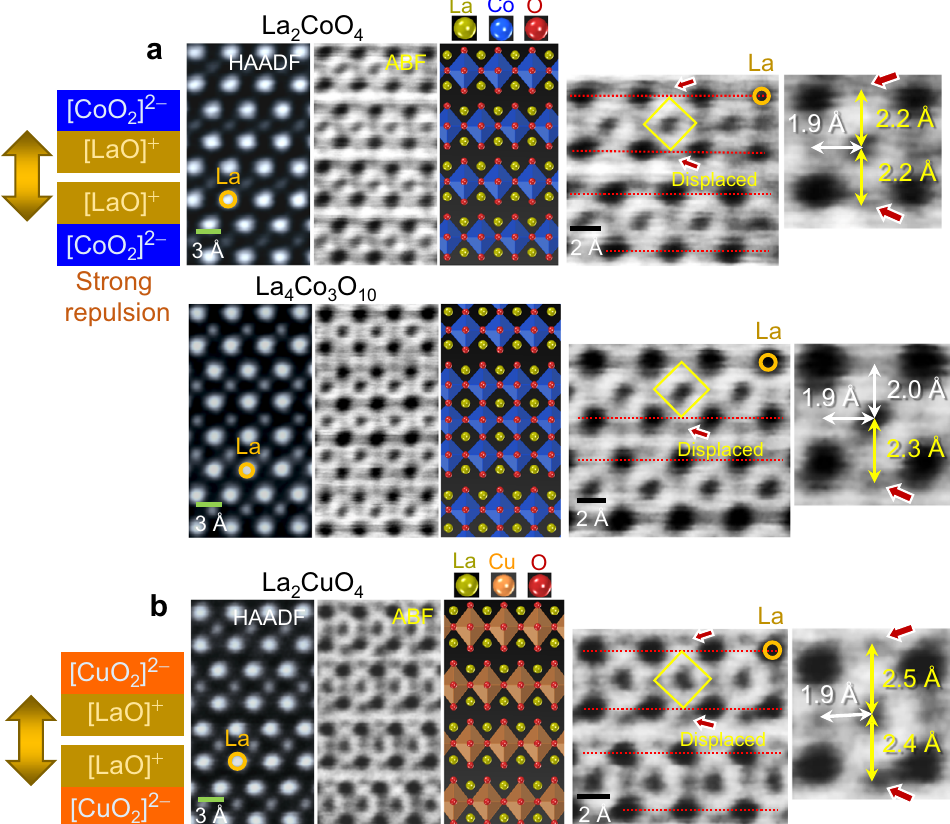
Fig. 7 STEM images showing the structure of La-based RP oxides. Atomic-column-resolved images were acquired in a La 2 CoO 4 and La 4 Co 3 O 10 and b La 2 CuO 4 , as listed in Supplementary Table 3. Strong local repulsion between [LaO] + sublayers is illustrated in the left-hand column. Signi fi cant elongation of the Co – O and Cu – O bonds at the shear planes is denoted by yellow arrows in the ABF images, providing quantitative information on the bond lengths. As Cu 2 + is known as a strong Jahn – Teller cation, {CuO 6 } octahedra in La 2 CuO 4 show more prominent z axis elongation. Red arrows in each image indicate substantial displacement of oxygen